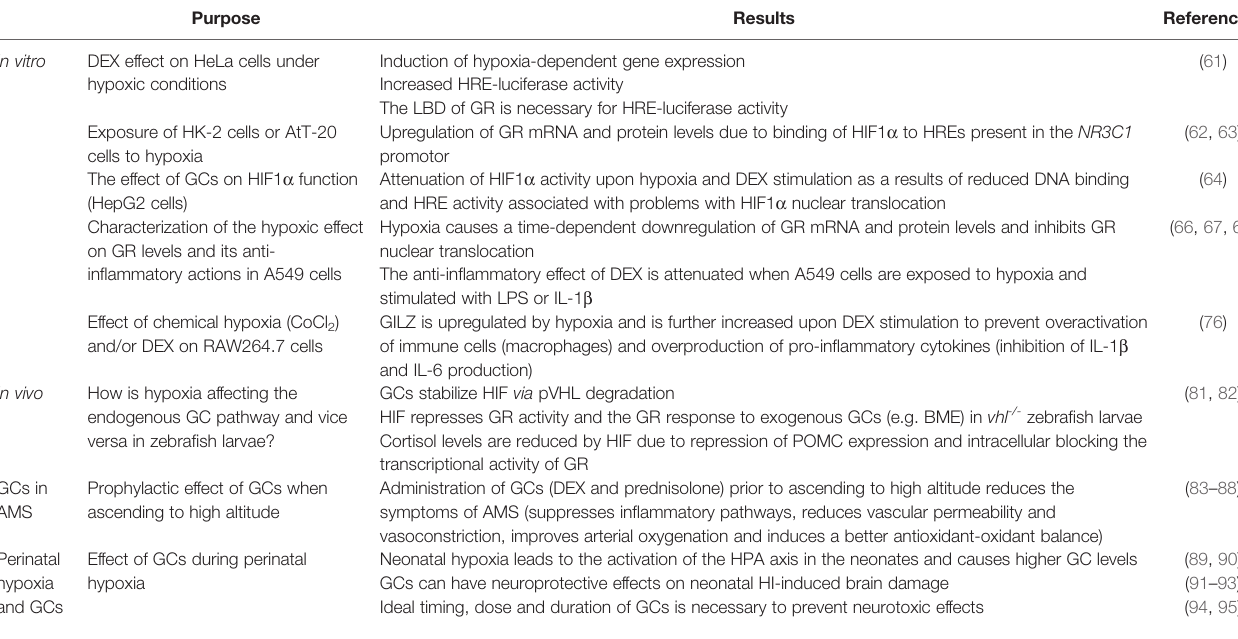
TABLE 1 | Overview of key studies concerning the bidirectional crosstalk between GC signalling and HIF mediated pathways.